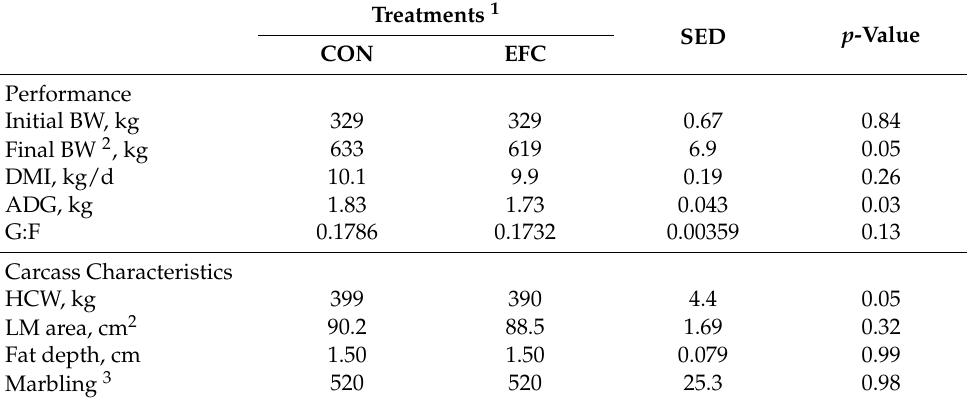
Table 4. Main effect of the corn hybrids (EFC vs. CON) fed as high-moisture corn with 18 or 20% distiller grains on predicted least-square means when finishing cattle performance and carcass characteristics are